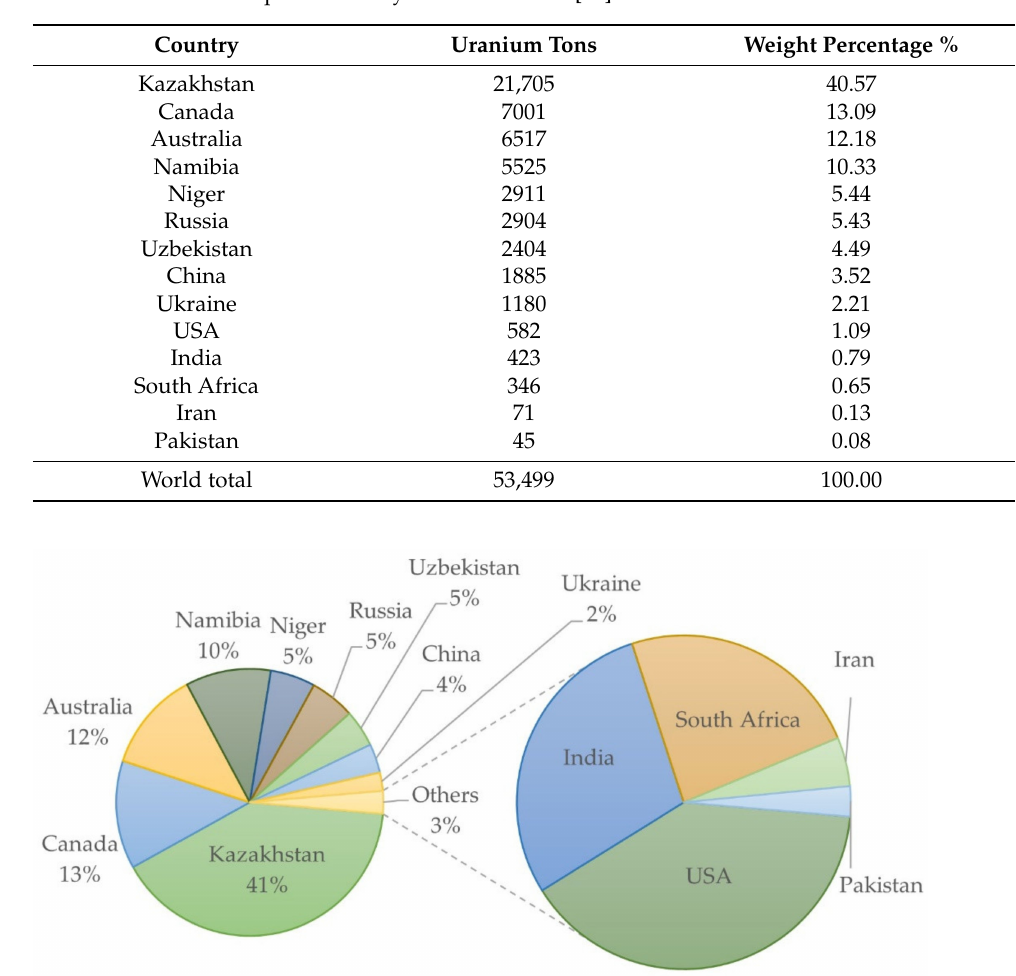
Figure 1. Mass flows in nuclear fuel production. Table 1. Total uranium production by counties in 2018 [18].